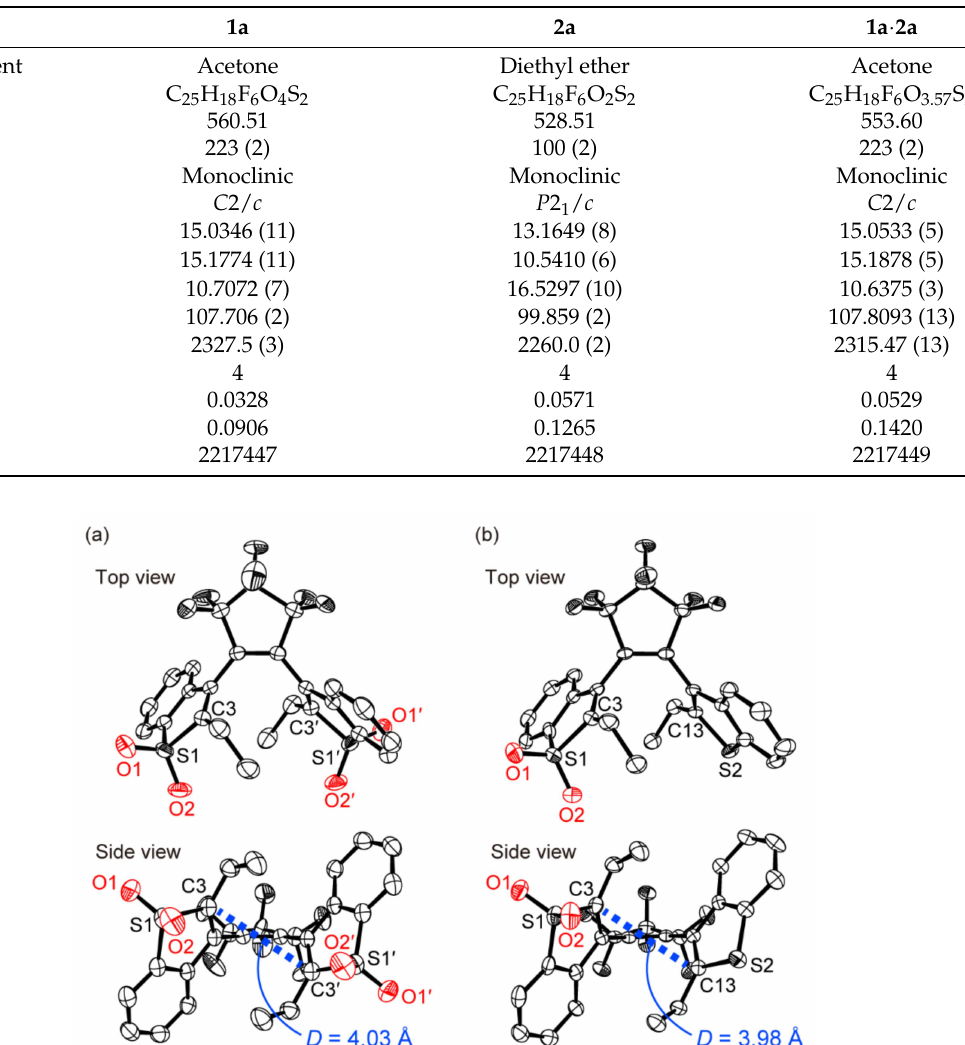
Table 1. Crystal data for single-component crystals of 1a and 2a and a two-component mixed crystal